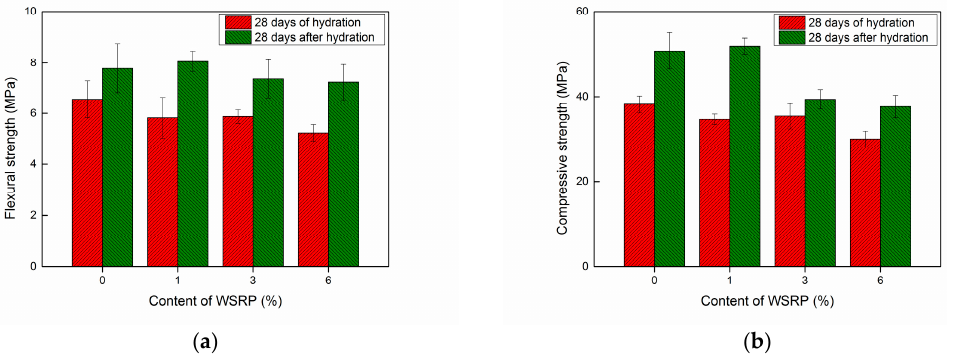
Figure 8. Influence of WSRPs incorporation on the ( a ) flexural strength and ( b ) compressive strength of specimens at different ages (28 days of hydration and 28 days storage at lab environment after 28 days of hydration).